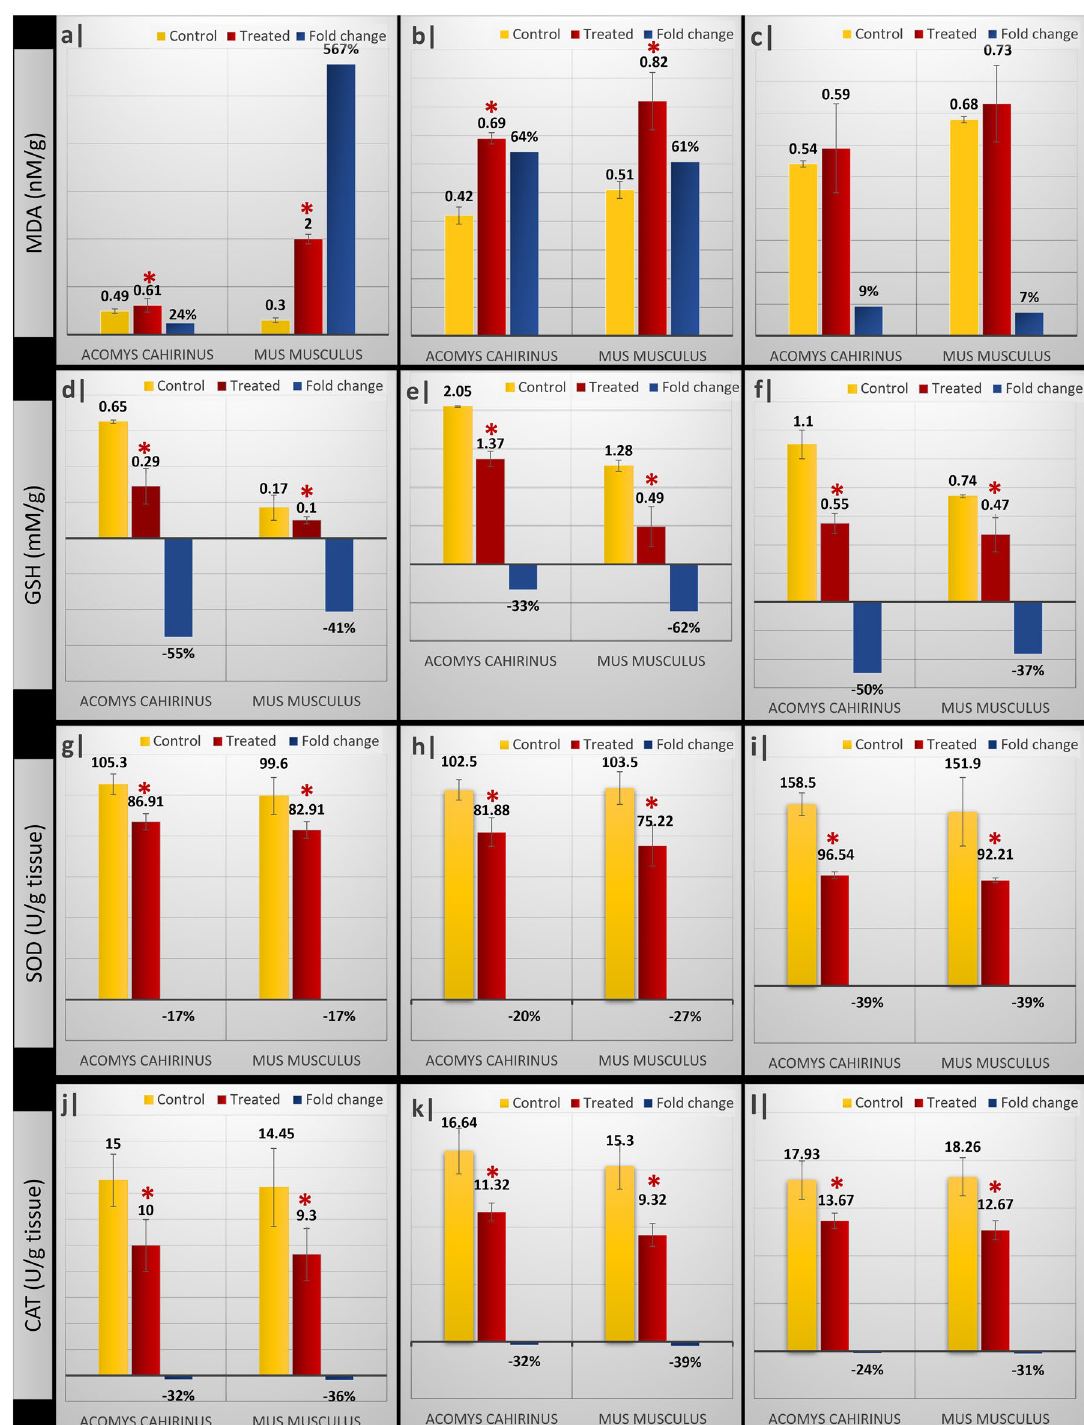
Figure 4. Effect of subacute administration of LA (multiple doses; 50 mg/kg for five consecutive days) on oxidative stress biomarkers: MDA brain ( a )–liver ( b )–kidneys ( c ), GSH content of brain ( d )–liver ( e )–kidneys ( f ), SOD activity of brain ( g )–liver ( h )–kidney ( i ) and finally CAT activity of brain ( j )–liver ( k )–kidney ( l ) of control and treated experimental groups of Acomys cahirinus and Mus musculus . Data presented as mean ± standard error of mean. Fold change represents the percentage change relative to the corresponding control groups. Asterisk: significant ( p < 0.05) difference as compared with the corresponding control